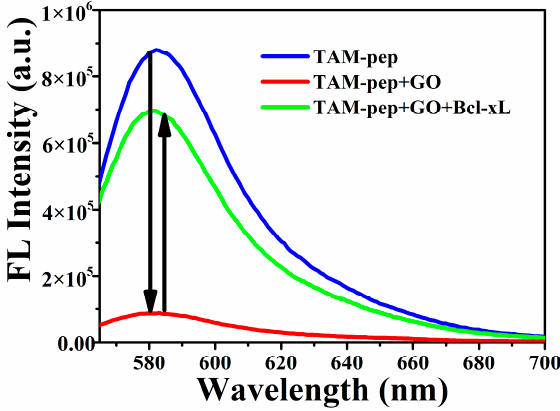
Figure 1. Fluorescence emission spectra of 100 nM TAM-PEP (R8) under different conditions: the fluorescence spectrum of TAM modified peptide (blue line), the fluorescence spectrum of GO-quenched signal (red line), and 5 µ M Bcl-xL triggered turn-on fluorescence spectrum (green line). Ex = 540 nm.